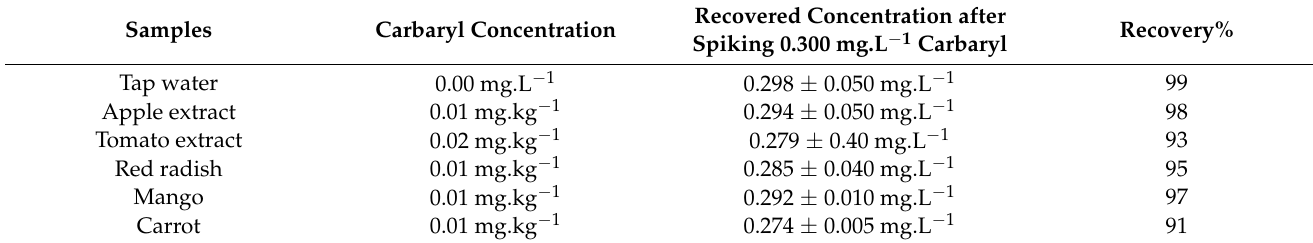
Table 2. The recovery of carbaryl from the water and food samples ( n =